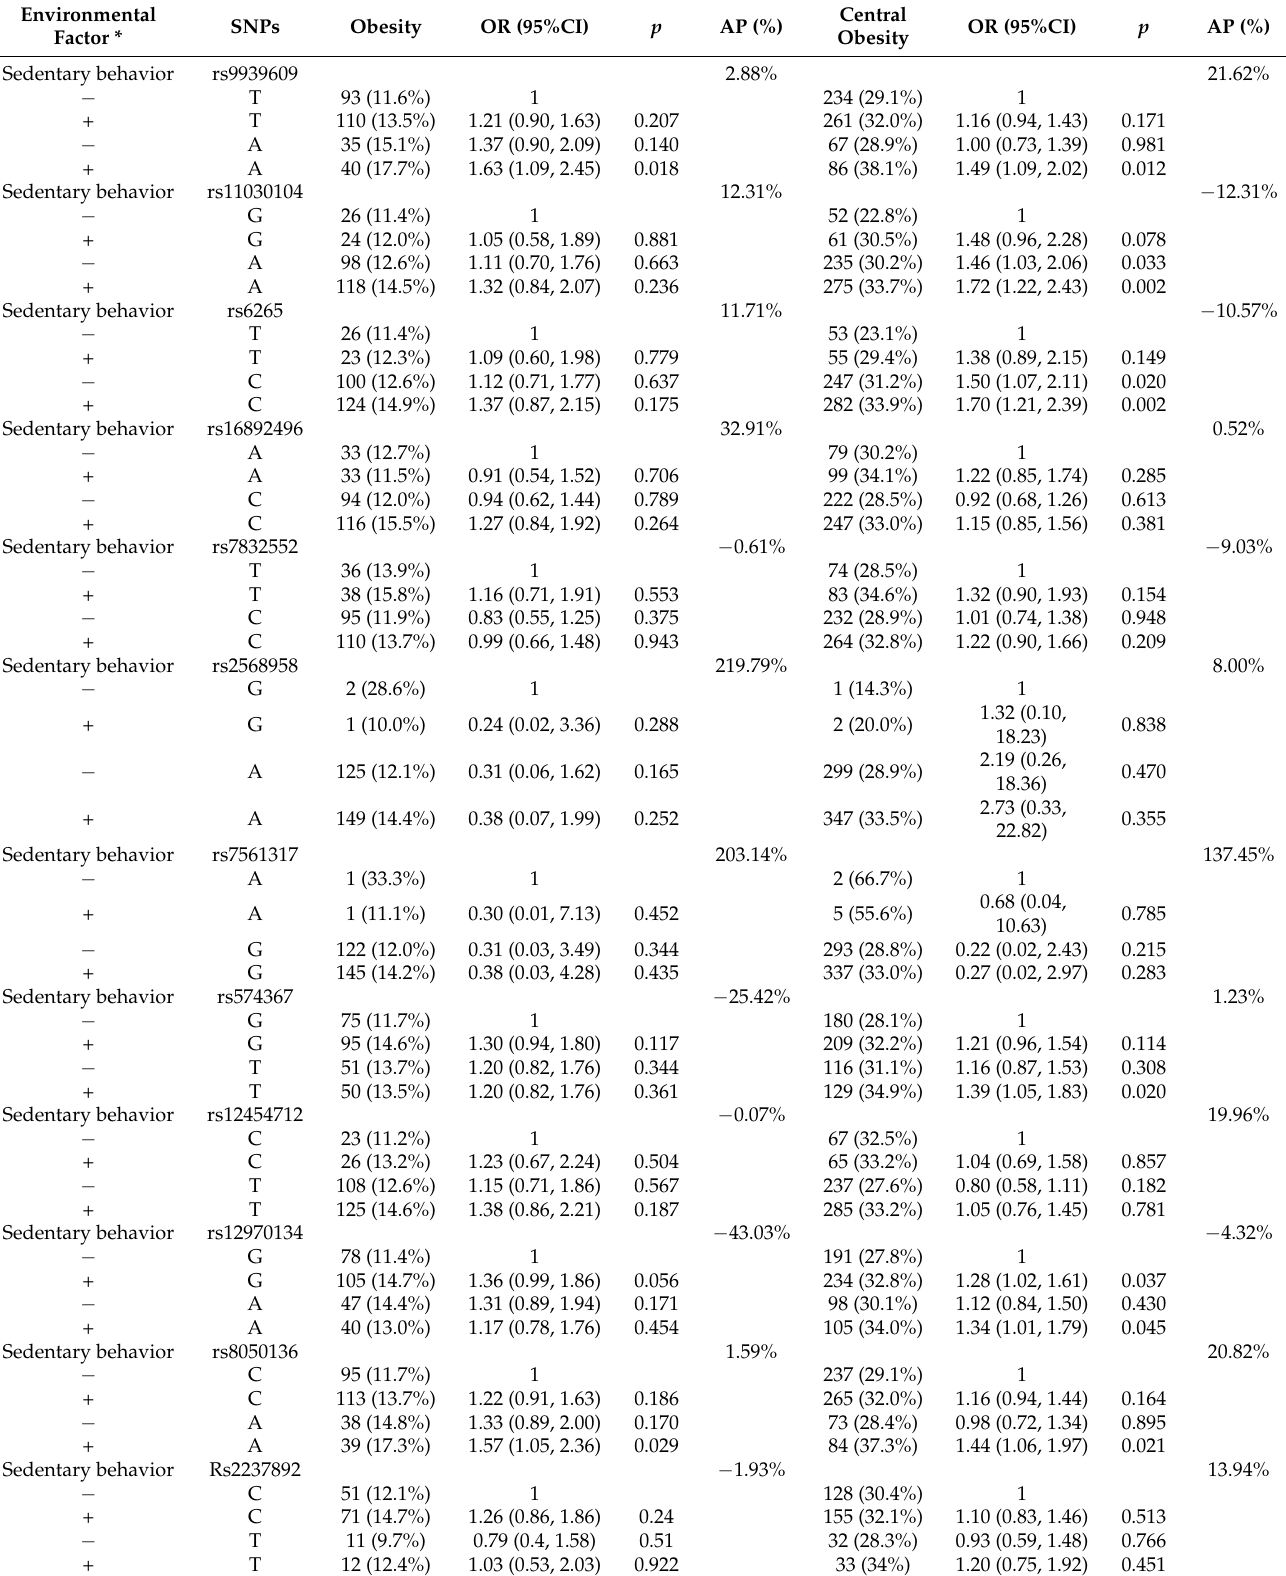
Table 7. The interaction between sedentary behavior and SNPs in obesity and central